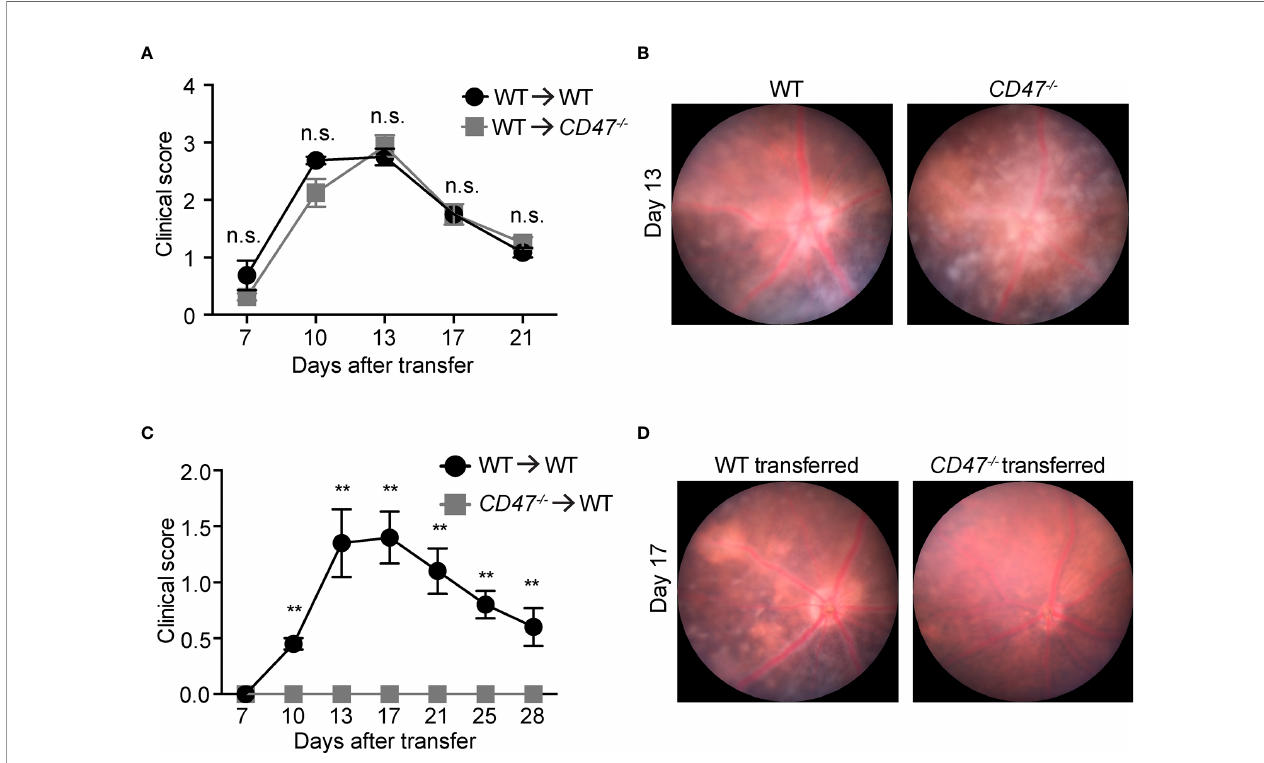
FIGURE 3 | CD47 de fi ciency in systemic immune cells but not locally in the eye is protective for autoimmune uveitis. Time course of clinical score and representative fundus images using adoptive transfer EAU model. (A, B) WT donor mice were immunized and the primed cells were transferred to naive WT or CD47 -/- recipient mice. (A) Time course of EAU clinical scores were evaluated by fundus observation (n =4 mice per group) (B) Representative retinal fundus images on day 13. (C, D) WT and CD47 -/- donor mice were immunized and the primed cells were transferred to naive WT recipient mice. (C) Time course of EAU clinical scores were evaluated by fundus observation (n=5-6 mice per group) (D) Representative retinal fundus images on day 17. Data were analyzed by Mann – Whitney U test and expressed as mean ± SEM. **P<0.01; n.s., not signi fi